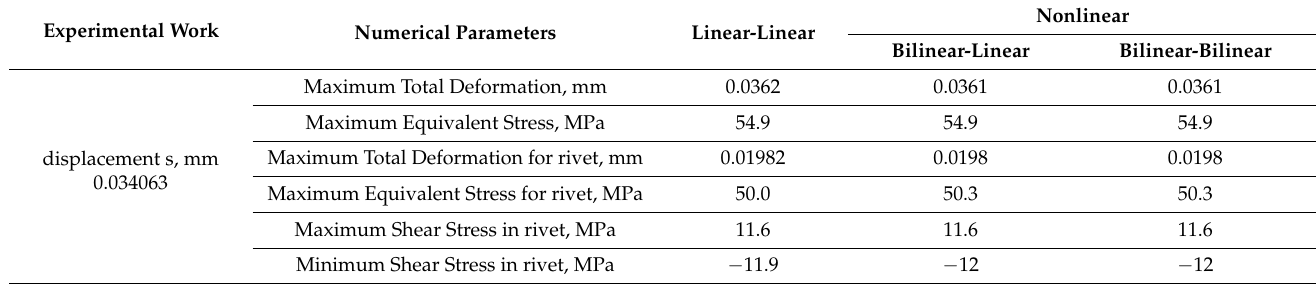
Table A1. Experimental and numerical results for the load force F = 100 N.